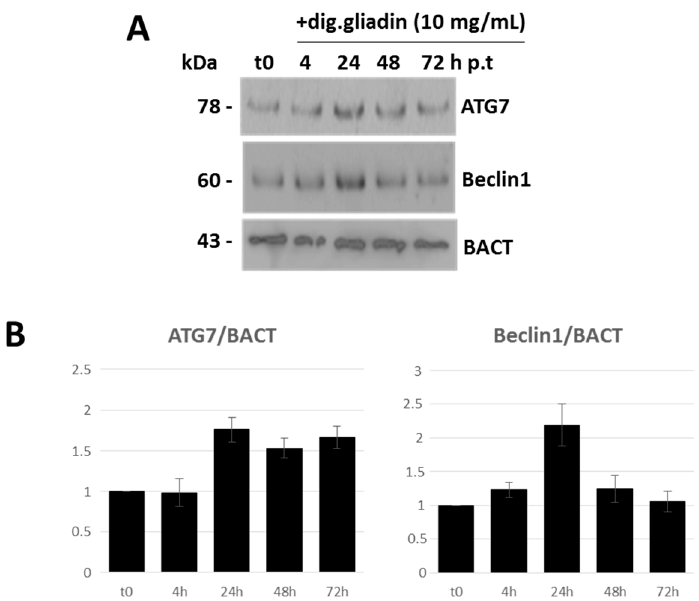
Figure 7. Immunoblotting analysis of autophagy proteins after digested gliadin administration in Caco-2 cells. ( A ) Caco-2 cells were incubated with digested gliadin (10 mg/mL) for different times. Then, proteins were extracted and assayed for expression of Atg7 and Beclin 1 proteins. Molecular weights (kDa) are reported; ( B ) Densitometric analysis was obtained after normalization with BACT expression and referred to untreated (t0) cells. p.t., post-treatment.